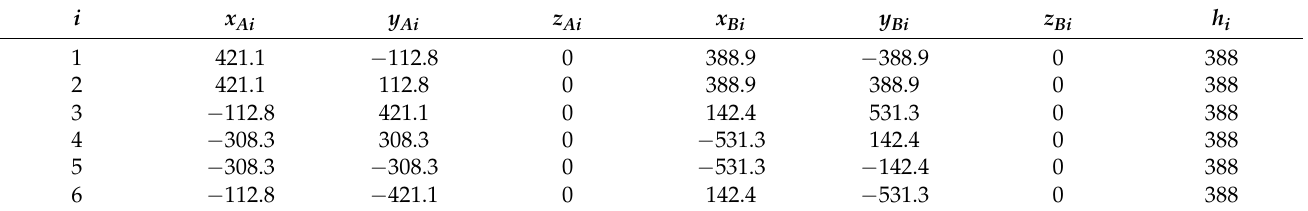
Table 2. Theoretical kinematic parameters of the six-hardpoint positioning mechanism (unit: